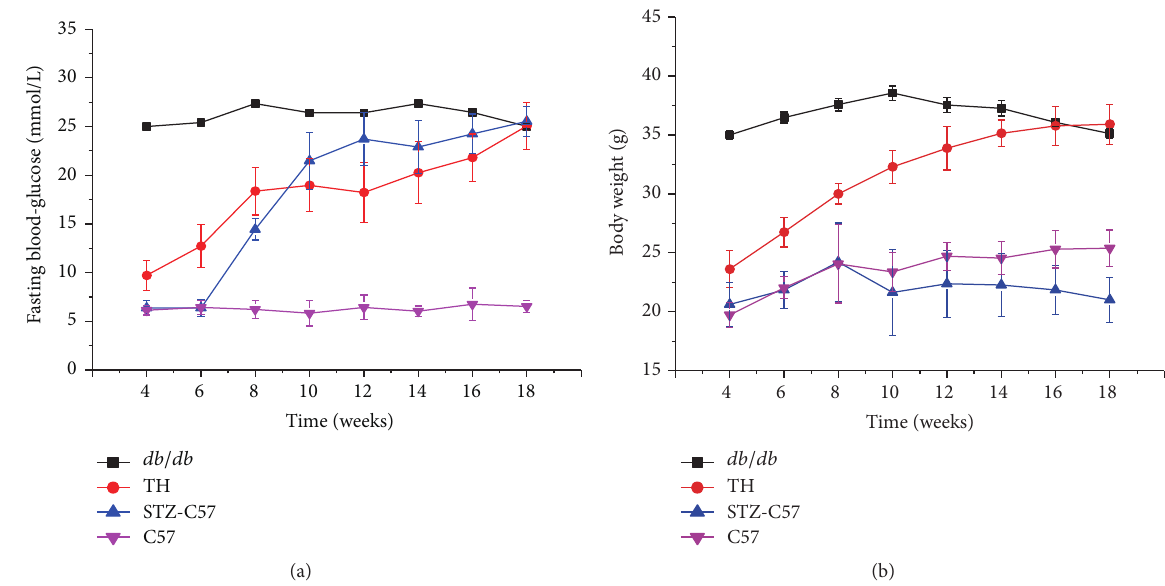
Figure 1: Fasting blood glucose (a) and body weight (b) levels in the infection groups of different mice. Values for each time point are expressed as mean ±